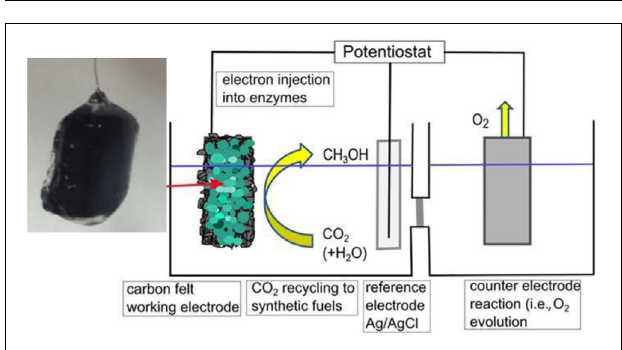
FIGURE 4 | Electrochemical cell for electroenzymatic CO 2